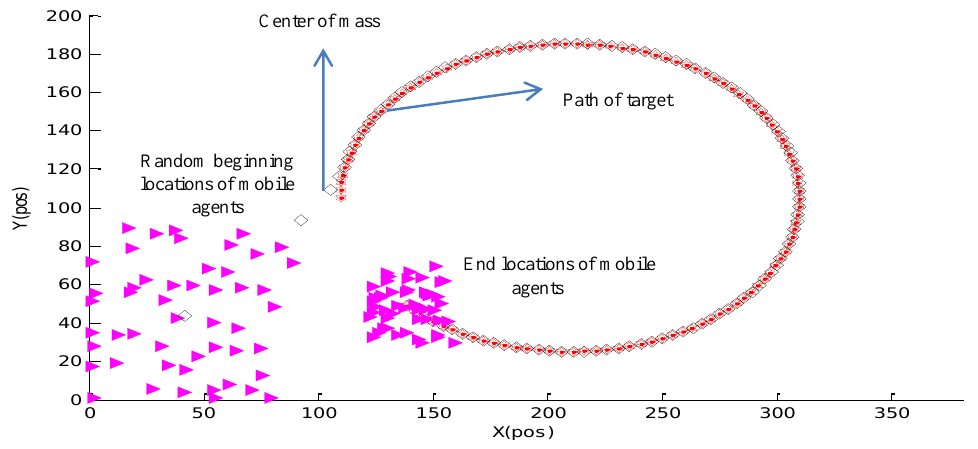
Figure 1. Beginning and ending locations of 50 mobile agents that are following a dynamic target in circular wave path with optimal parameters in table 1 by proposed flocking control algorithm using (11) and GSA.